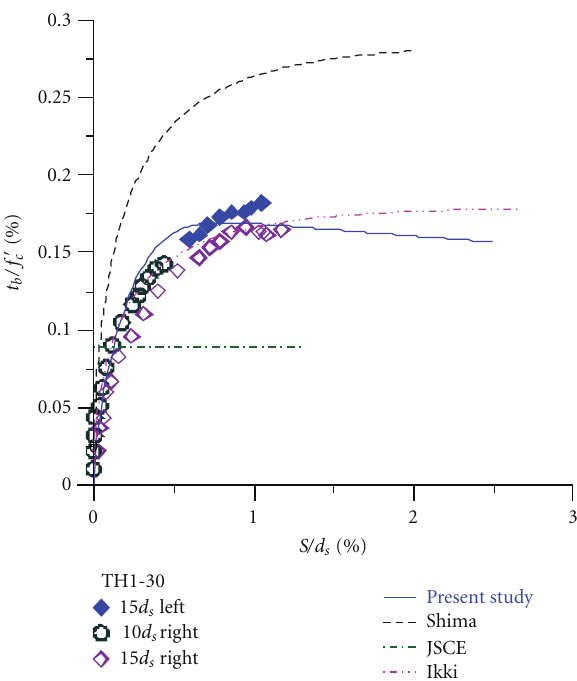
Figure 12: Bond stress-slip relationship of TH1-45